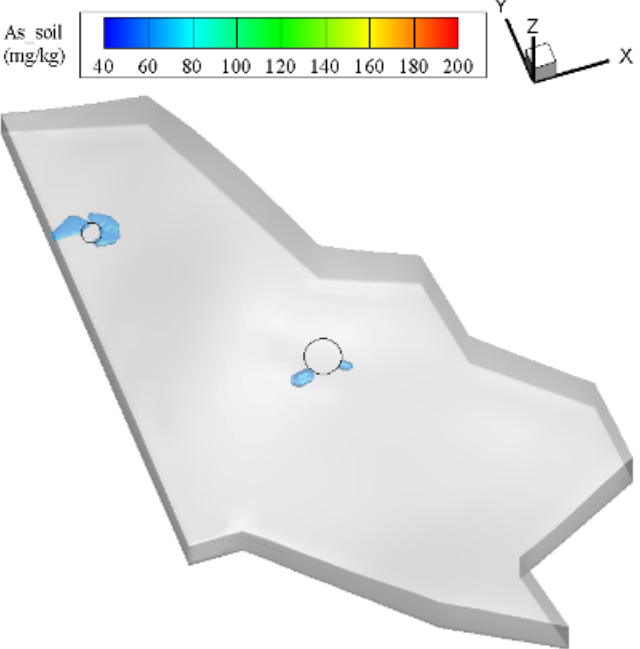
Figure 8. The excavation locations corresponding to the minimum amount of the contaminated soil to be excavated to prevent groundwater contamination as described in the text. The As_soil was soil arsenic concentration. The blue blocks are the residual contaminated soil exceeded 60 mg/kg. The black circles are the excavation locations.